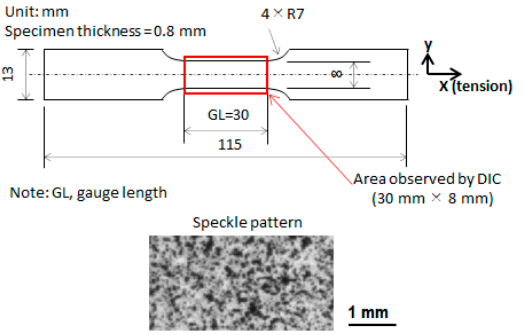
Figure 1. The size of the dog-bone-type specimen and the spackle patterns on the front surface of the specimen.